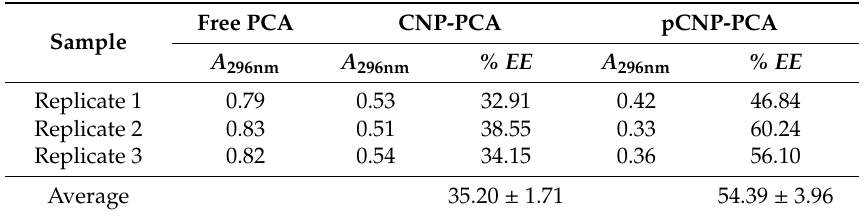
Table 1. Encapsulation e ffi ciency ( % EE ) of 500 µ M PCA in CNP-PCA and pCNP-PCA nanoparticles. E ffi ciency of the phenolic compound in pCNP-PCA was higher than CNP-PCA due to its active hydrophobic-hydrophobic interaction with palmitoyl in the hydrophobically-modified nanoparticle. Data are presented as mean ± SEM from three independent experiment